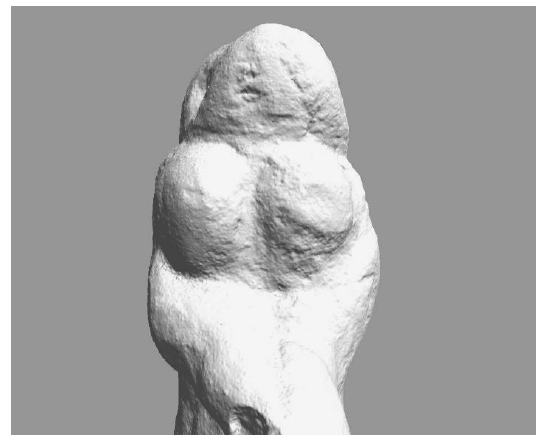
Figure 16. Some details on the 3D model of the